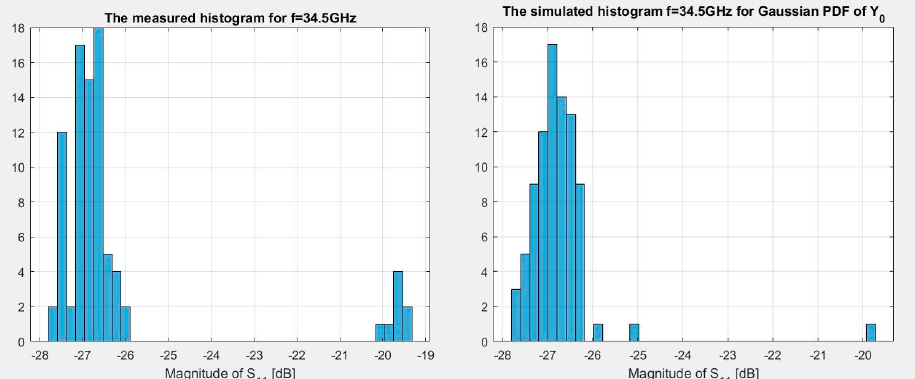
Figure 7. Histogram of | S 11 | obtained from the measurements and simulation results for σ y0 = 0.025 mm for antenna design from Figure 2 for the frequency of 34.5 GHz.